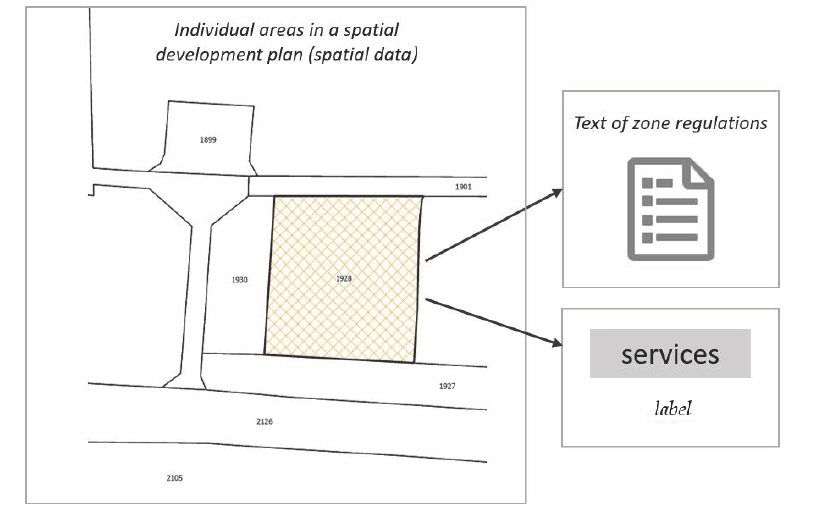
Figure 2. Representation of the